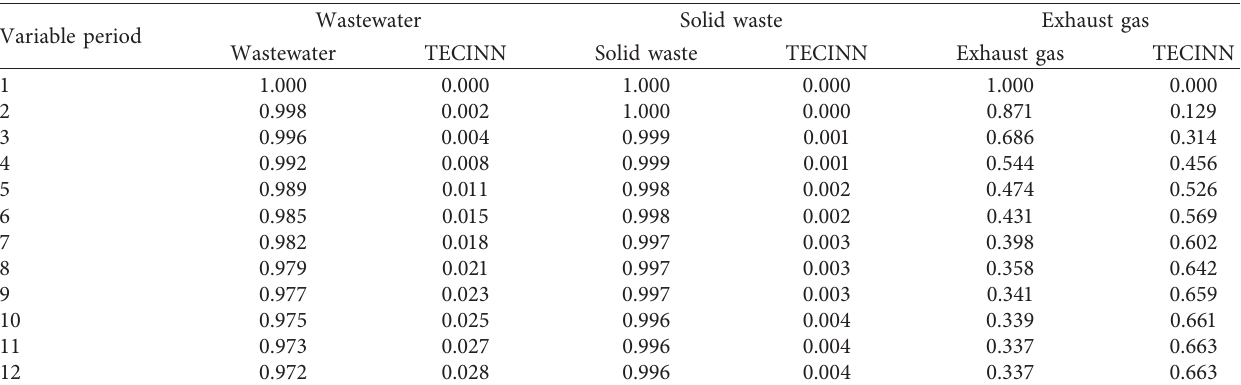
Table 6: Variance